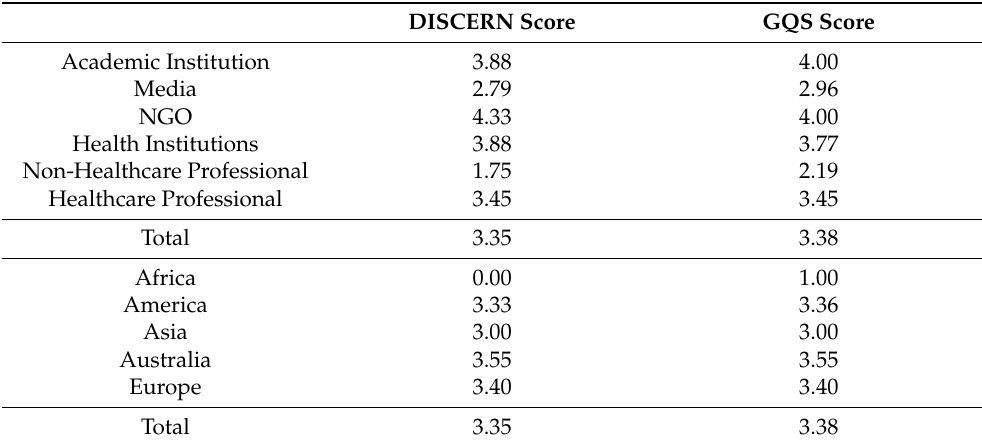
Table 2. DISCERN and GQS